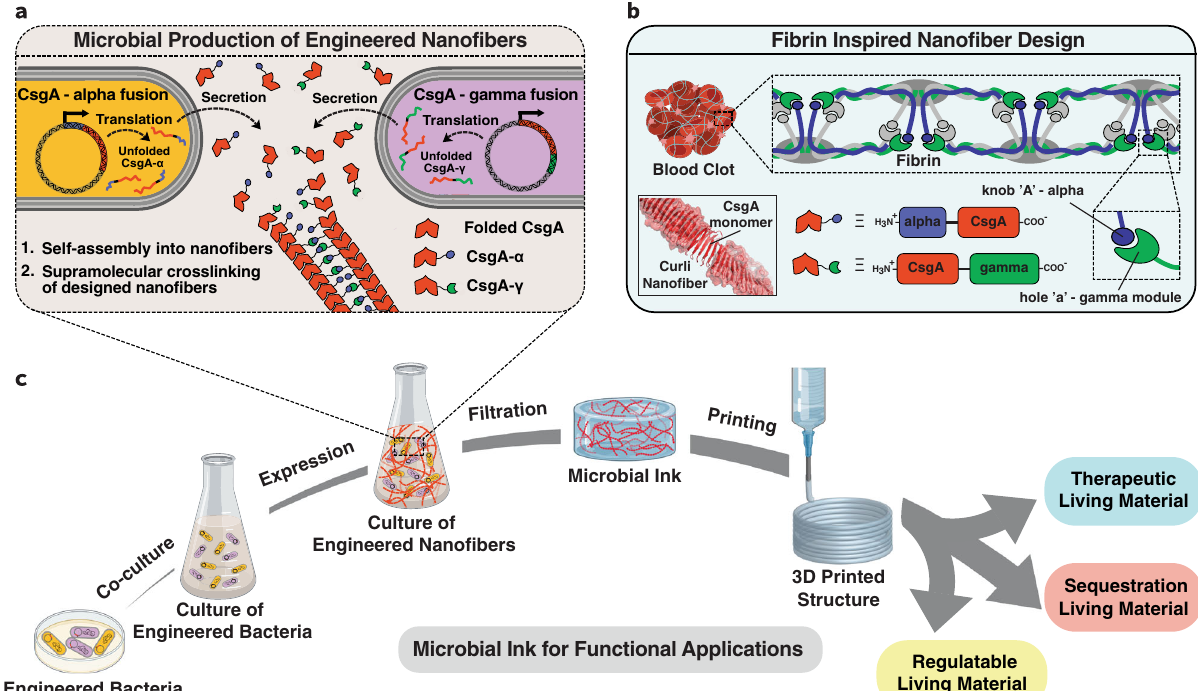
Fig. 1 Schematics of the design strategy, production, and functional applications of microbial ink. a E. coli was genetically engineered to produce microbial ink by fusing α (knob) and γ (hole) protein domains, derived from fi brin to the main structural component of curli nano fi bers, CsgA. Upon secretion, the CsgA- α and CsgA- γ monomers self-assemble into nano fi bers crosslinked by the knob-hole binding interaction. b The knob and hole domains are derived from fi brin, where they play a key role in supramolecular polymerization during blood clot formation. c The protocol to produce microbial ink from the engineered protein nano fi bers involves standard bacterial culture, limited processing steps, and no addition of exogenous polymers. Microbial ink was 3D printed to obtain functional living